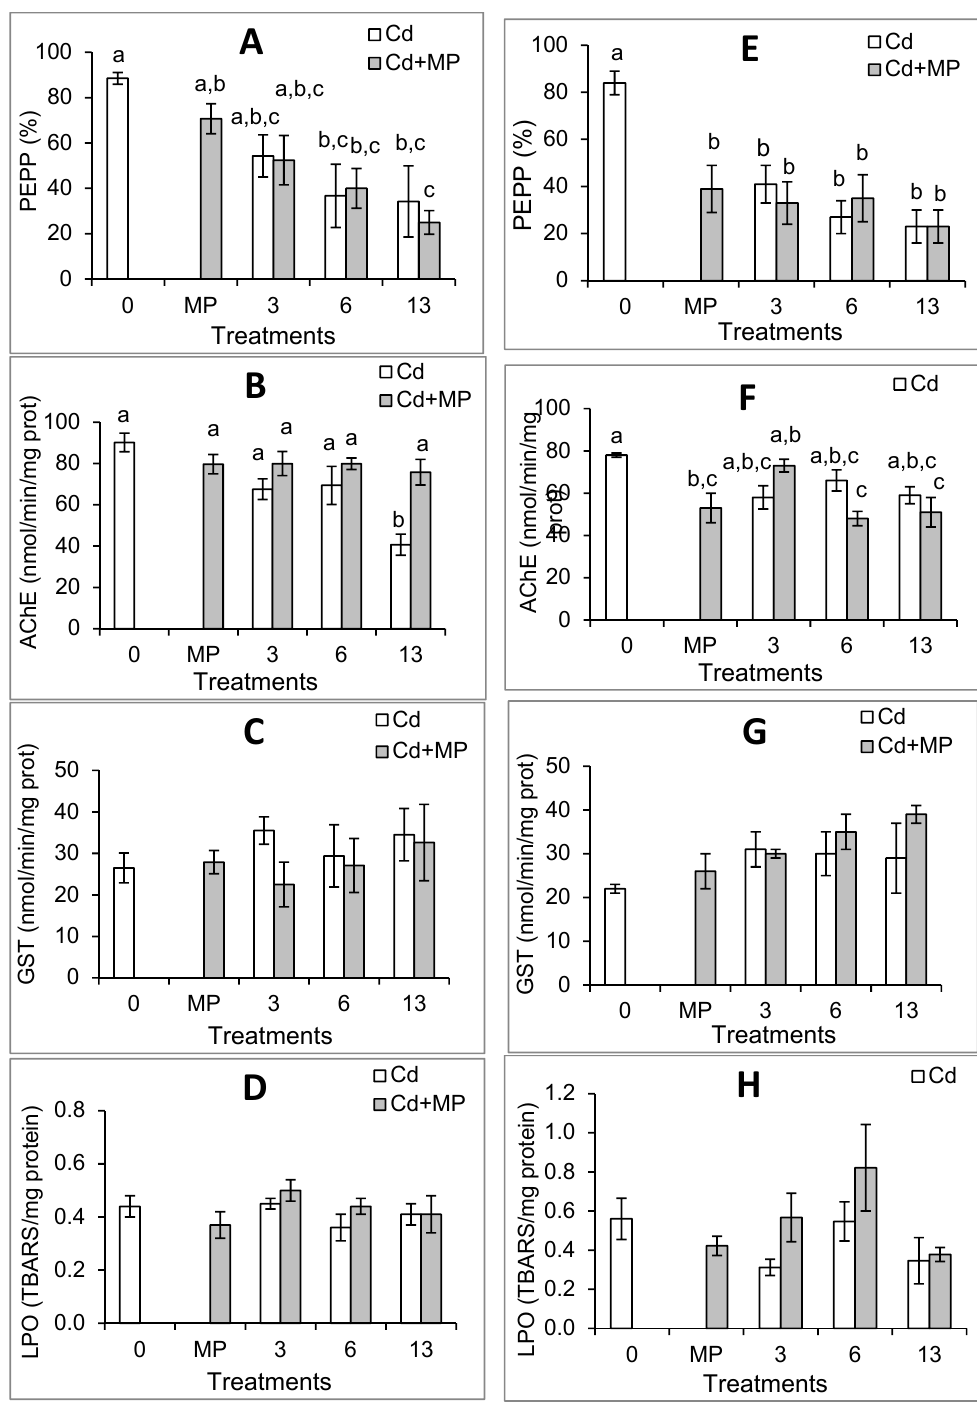
Figure 1. Mean and standard error ( N = 3–9 per treatment) of predatory performance, acetylcholinesterase activity and lipid peroxidation levels Pomatoschistus microps juveniles from the estuaries of Minho (A–D) and Lima (E-H) Rivers exposed to cadmium and microplastics individually and in mixture. A and E—predatory performance. B and F—Acetylcholinesterase activity. C and G—Glutathione S -transferases activity. D and H—Lipid peroxidation levels. 0—control. MP—treatment containing 0.14 mg/L of microplastics only. 3, 6, 13—treatments containing 3, 6 and 13 mg/L of cadmium (alone or in mixture with microplastics). Di ff erent letters above the bars indicate statistically significant di ff erences among treatments (Tukey’s test, p ≤